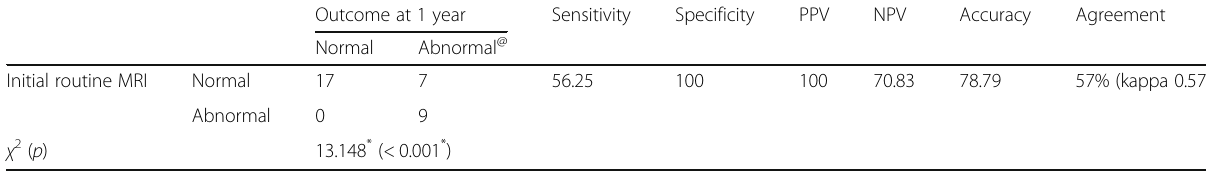
Table 2 Agreement of the initial routine MRI with final outcome